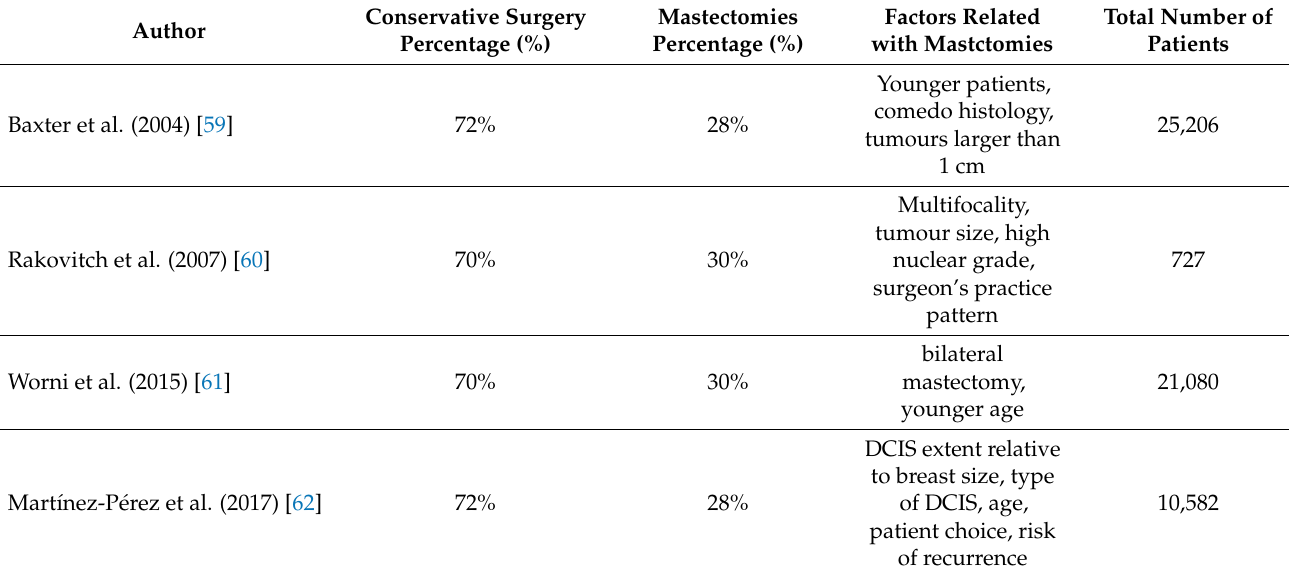
Table 10. Literature review: conservative surgery vs.